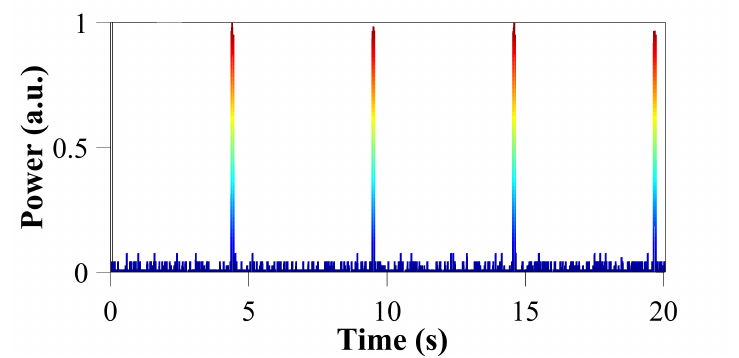
Figure 4. Spike train (T = 5 s, f = 0.2